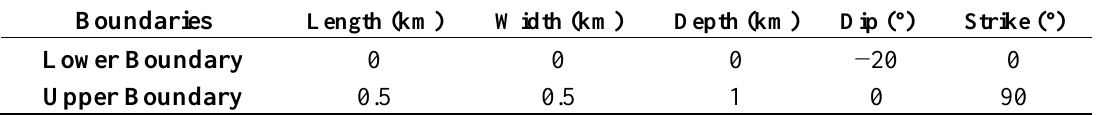
Table 1. Lower and upper boundaries used in the